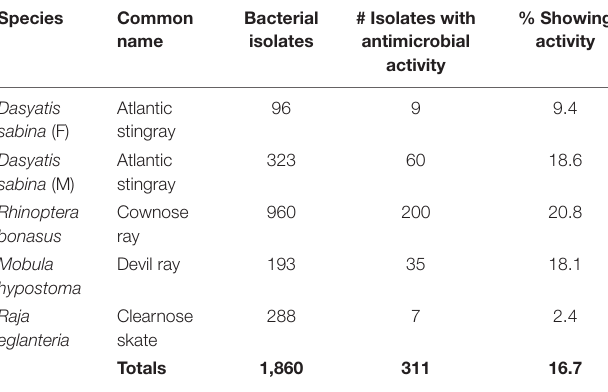
TABLE 1 | Compiled stingray and skate antibacterial screening